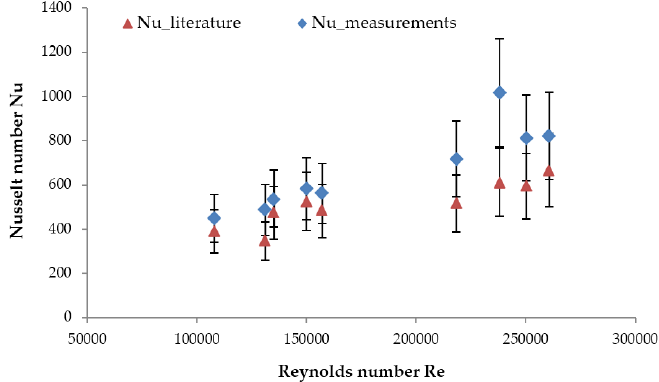
Figure 9. Comparison of the Nusselt number from the measurements and the Nusselt number from the literature correlation.